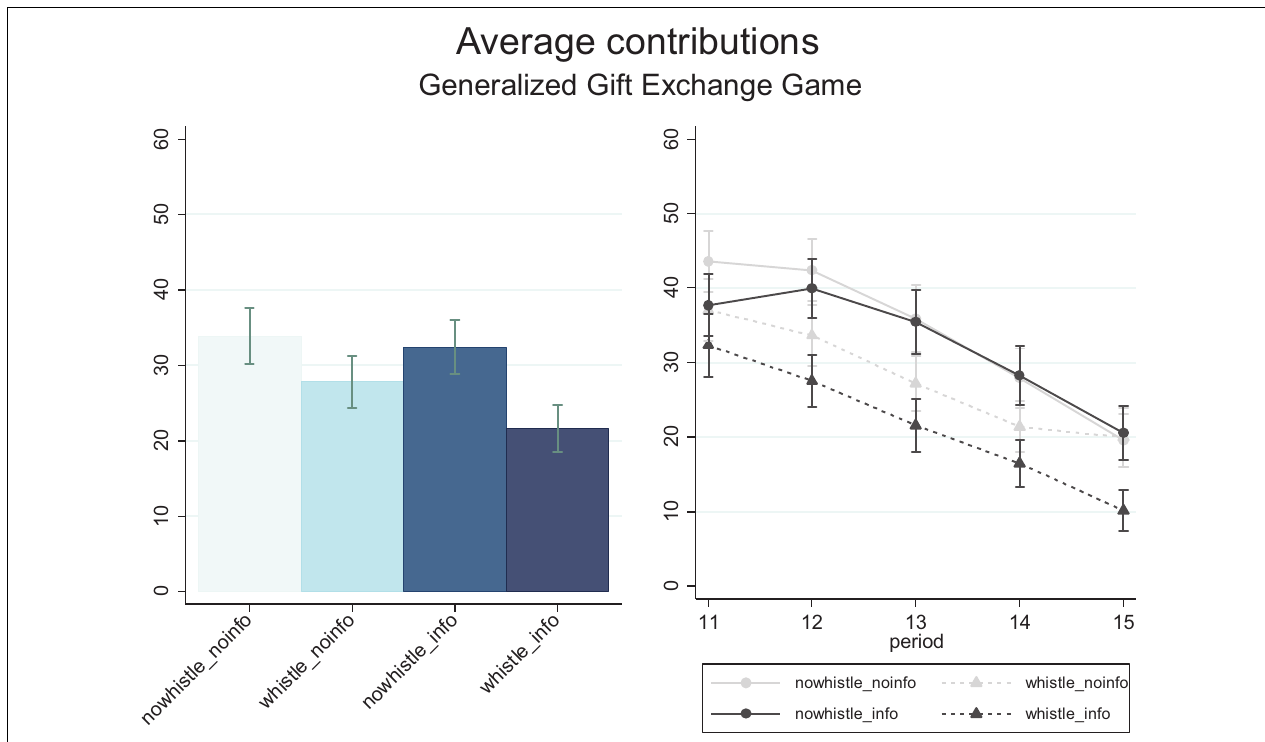
FIGURE 3 | Average contributions in the Generalized Gift Exchange Game by treatment (left-handed Panel) e by treatment and period (right-handed Panel). Error bars, mean ±